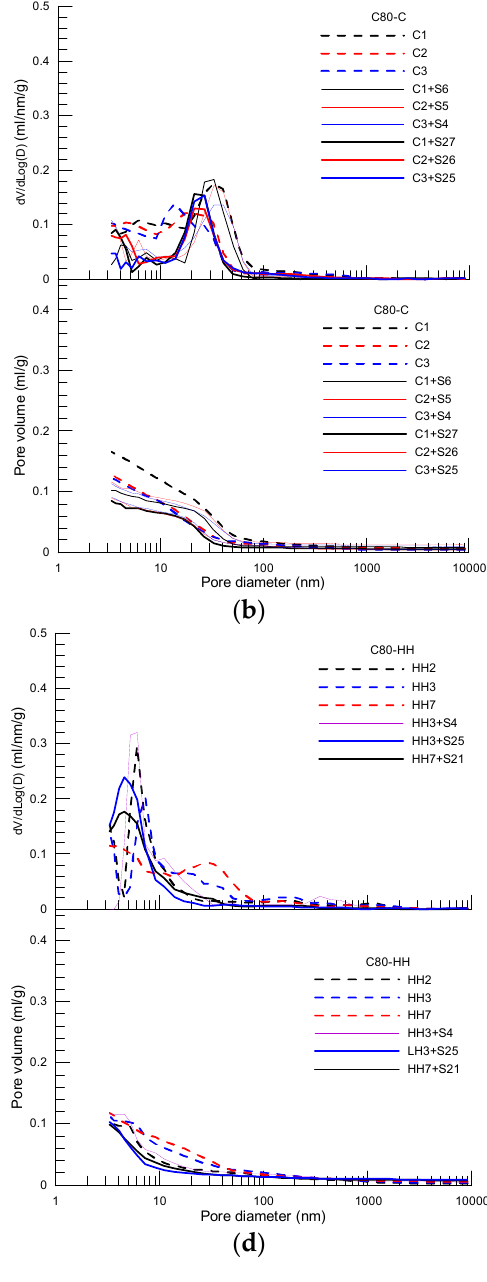
Figure 7. Cumulative (below) and derivative (above) pore volume versus pore diameter curves of the cement paste of C80 concrete subject to different curing procedures: ( a ) standard curing, ( b ) insulation cover curing, ( c ) heat curing with 40 °C and ( d ) heat curing with 60 °C.